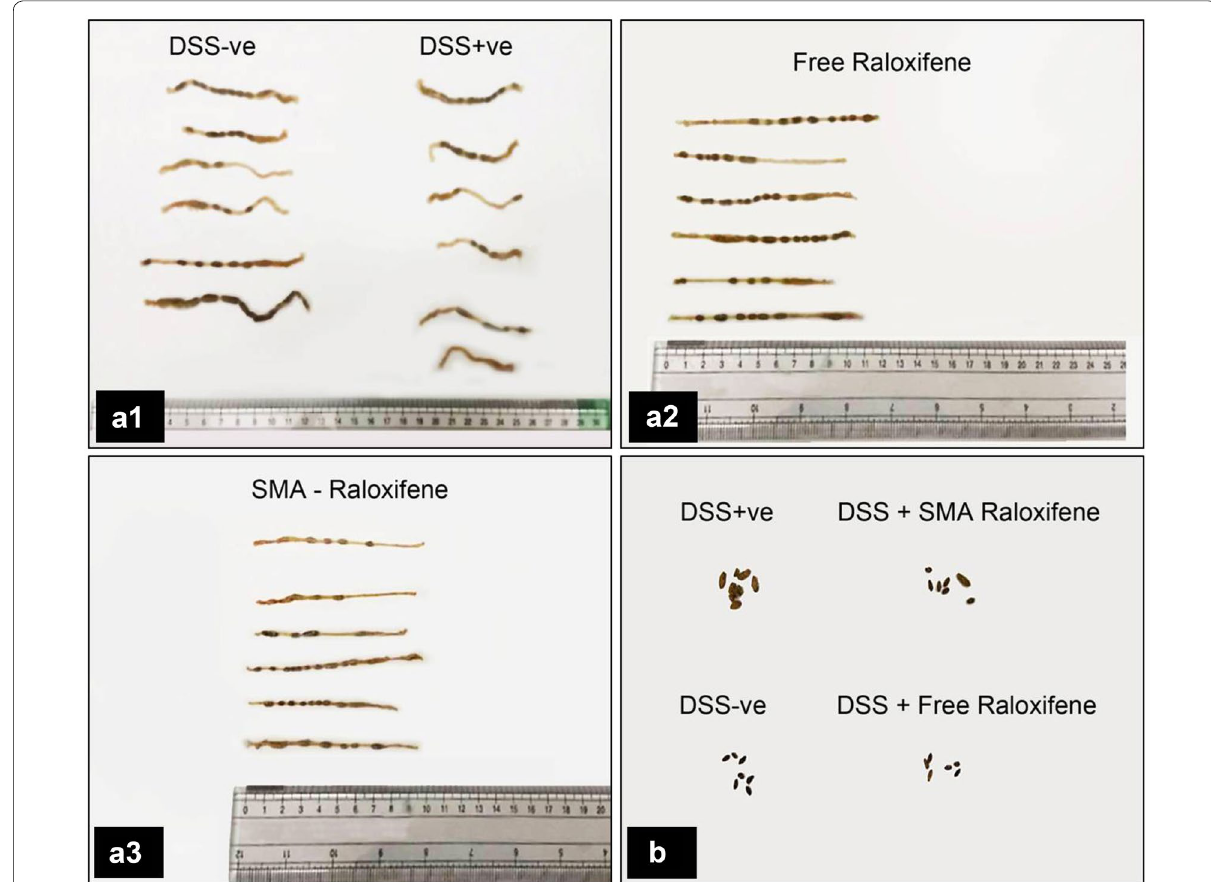
Fig. 7 a1 – a3 Effect of free and SMA Ral treatments compared to DSS on colon length. b Effect of free and SMA Ral treatments compared to DSS on stool